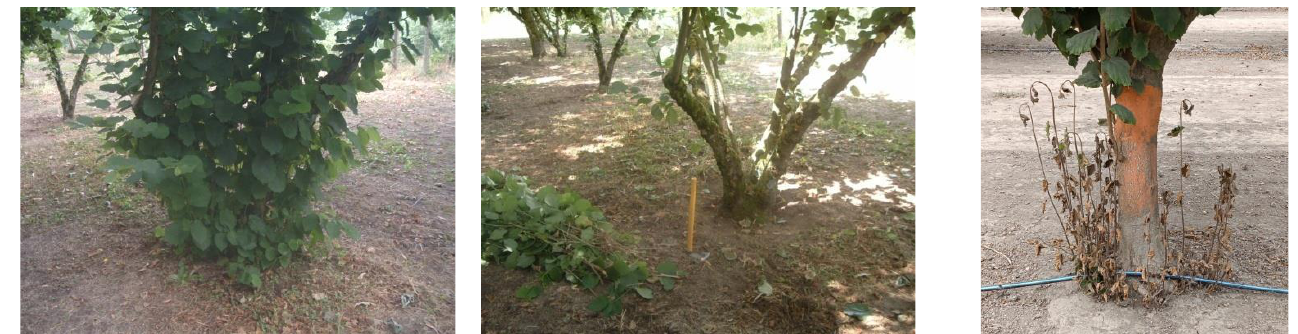
Figure 1. Comparison of manual and chemical hazelnut suckering (on the left : sucker canopy in multi-stemmed bush before manual suckering; in the middle : same multi-stemmed bush after manual suckering carried out in early summer; to the right : hazelnut suckers in wilted stage after chemical treatment).